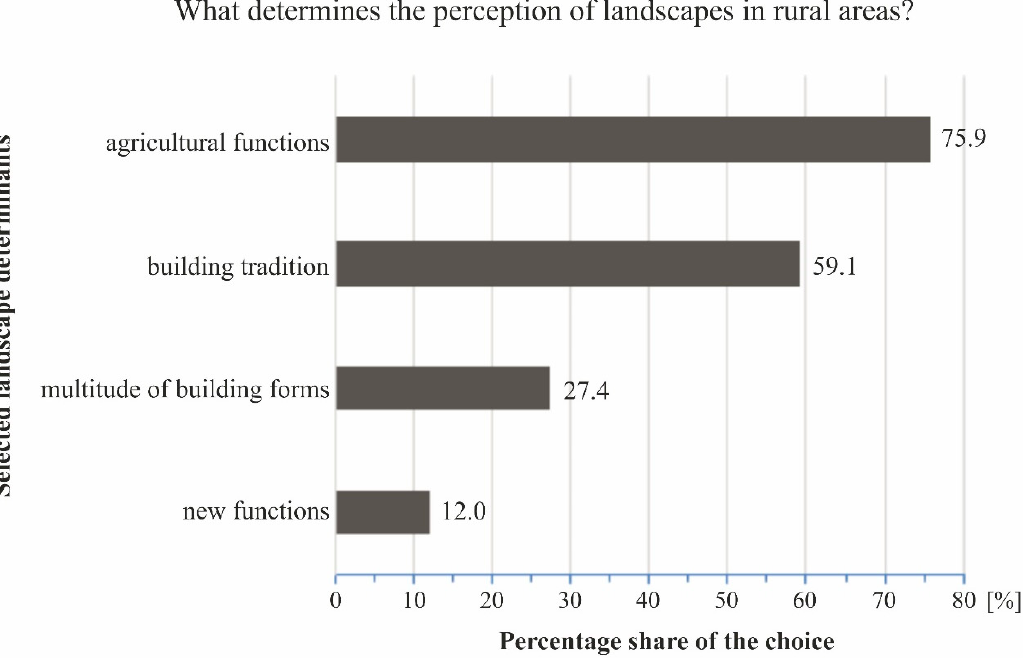
Figure 4. Characteristics determining the perception of the rural landscape (EnvEng and CivEng students combined, n = 244).